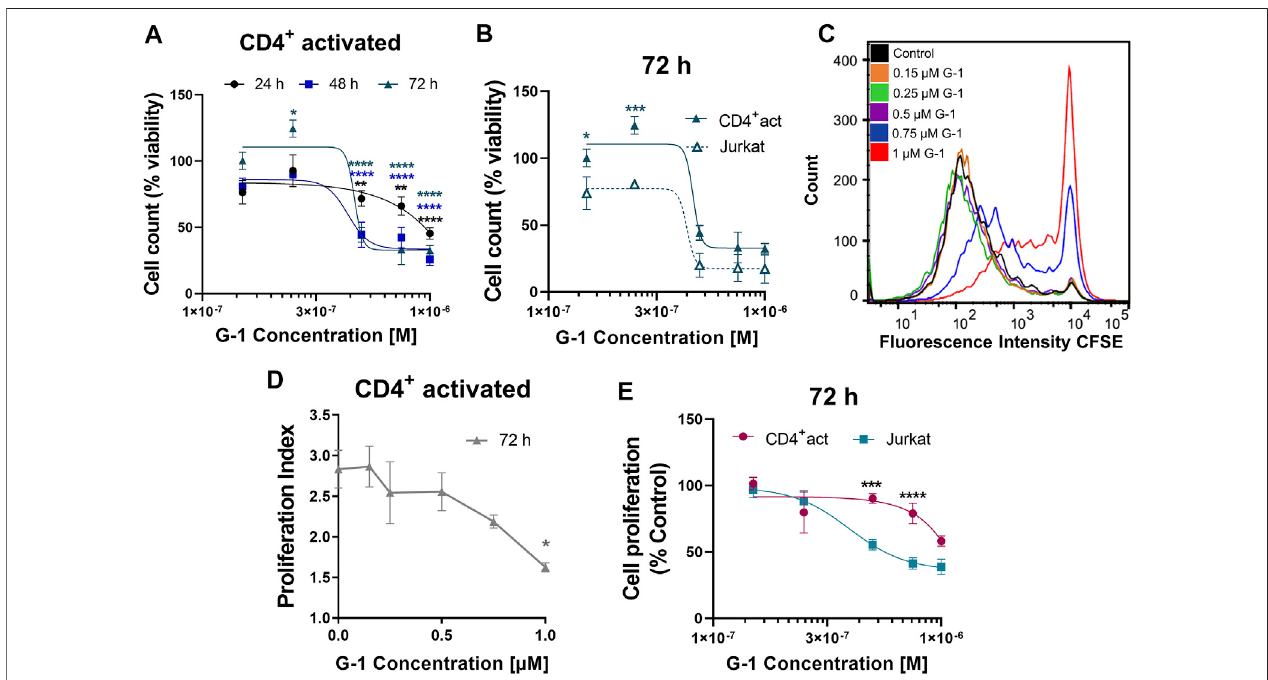
FIGURE 6 | Effect of G-1 on cell viability and proliferation of CD4 + lymphocytes. (A) Viability of activated non-leukemic CD4 + lymphocytes evaluated by cell count (the trypan blue exclusion test) and expressed as a function of G-1 concentration. Data are mean ± SEM. Comparison between control and treated samples was performed by one-way ANOVA with Dunnett post hoc testing. N ≥ 3; * p < 0.05, ** p < 0.01, **** p < 0.0001. (B) Comparison of viability (cell count) non-leukemic CD4 + lymphocytesandJurkatcellstreatedwithdifferentconcentrationsofG-1wasperformedbytwo-wayANOVAwiththeSidak posthoc test.Dataaremean±SEM;N ≥ 3; * p < 0.05, *** p < 0.001. (C) Representative fl owcytometryhistogramofCFSE fl uorescence intensitymeasured in activated CD4 + lymphocytestreatedwithdifferent concentrations of G-1 for 72 h. (D) Proliferation index expressed as a function of G-1 concentration (FlowJo Software, proliferation tool). Data are mean ± SEM; N = 3; * p < 0.05. Statistical signi fi cance was obtained by means of comparing each G-1 concentration to their control with a one-way ANOVA and a Dunnett post hoc testing. (E) Comparison of the decrease in cell proliferation caused by G-1 in CD4 + lymphocytes and Jurkat cells. Data are mean ± SEM; *** p < 0.001, **** p < 0.0001. Comparison between the CD4 + -activated lymphocyte group (pink line) and Jurkat cell line (blue line) was made by two-way ANOVA with Sidak post hoc